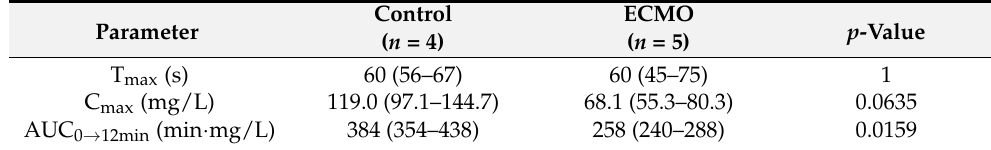
Figure 3. Evolution of amiodarone concentration after administration of a 300 mg amiodarone bolus along the in vivo experiment for ECMO group (yellow line) and control group (blue line) plotted as mean ± standard deviation. Table 2. Amiodarone pharmacokinetic parameters (T max , C max and AUC 0 → 12min ) directly observed or calculated from amiodarone concentrations determined along the in vivo experiment. Data are presented as median and interquartile range. Statistical analysis was performed by Mann–Whitney test ( p < 0.05).